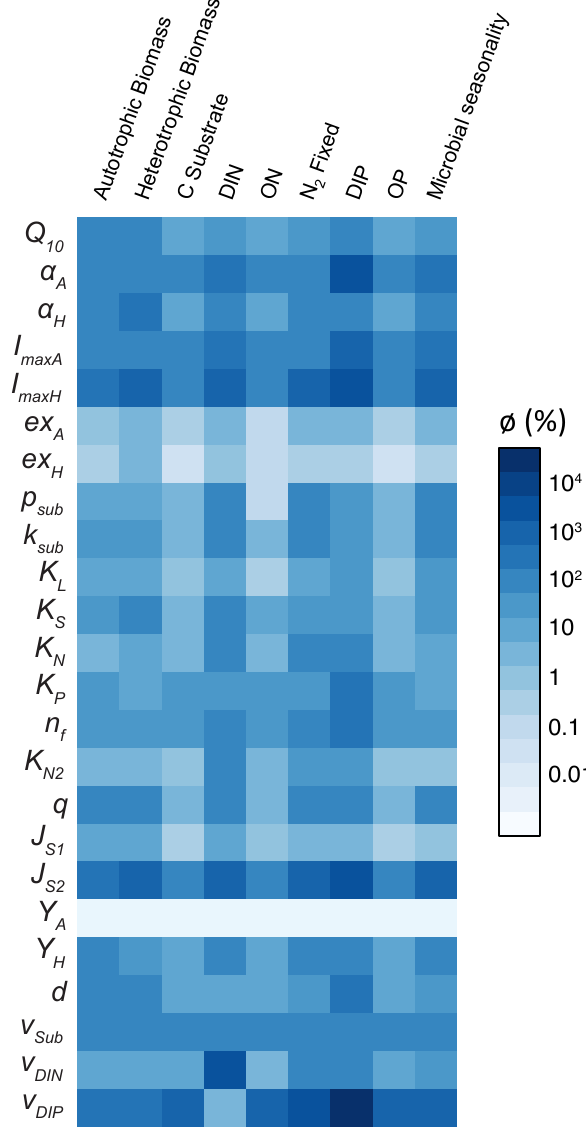
Figure 10. Heat map showing uncertainty of model outputs (ø) aris- ing from individual parameters. The model is forced with meteoro- logical data from the Damma Glacier (Fig. 4) over 75